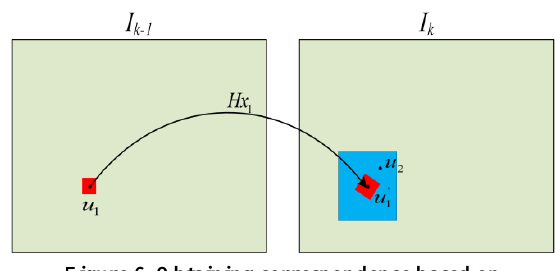
Figure 6. Obtaining correspondence based on homography matrix.